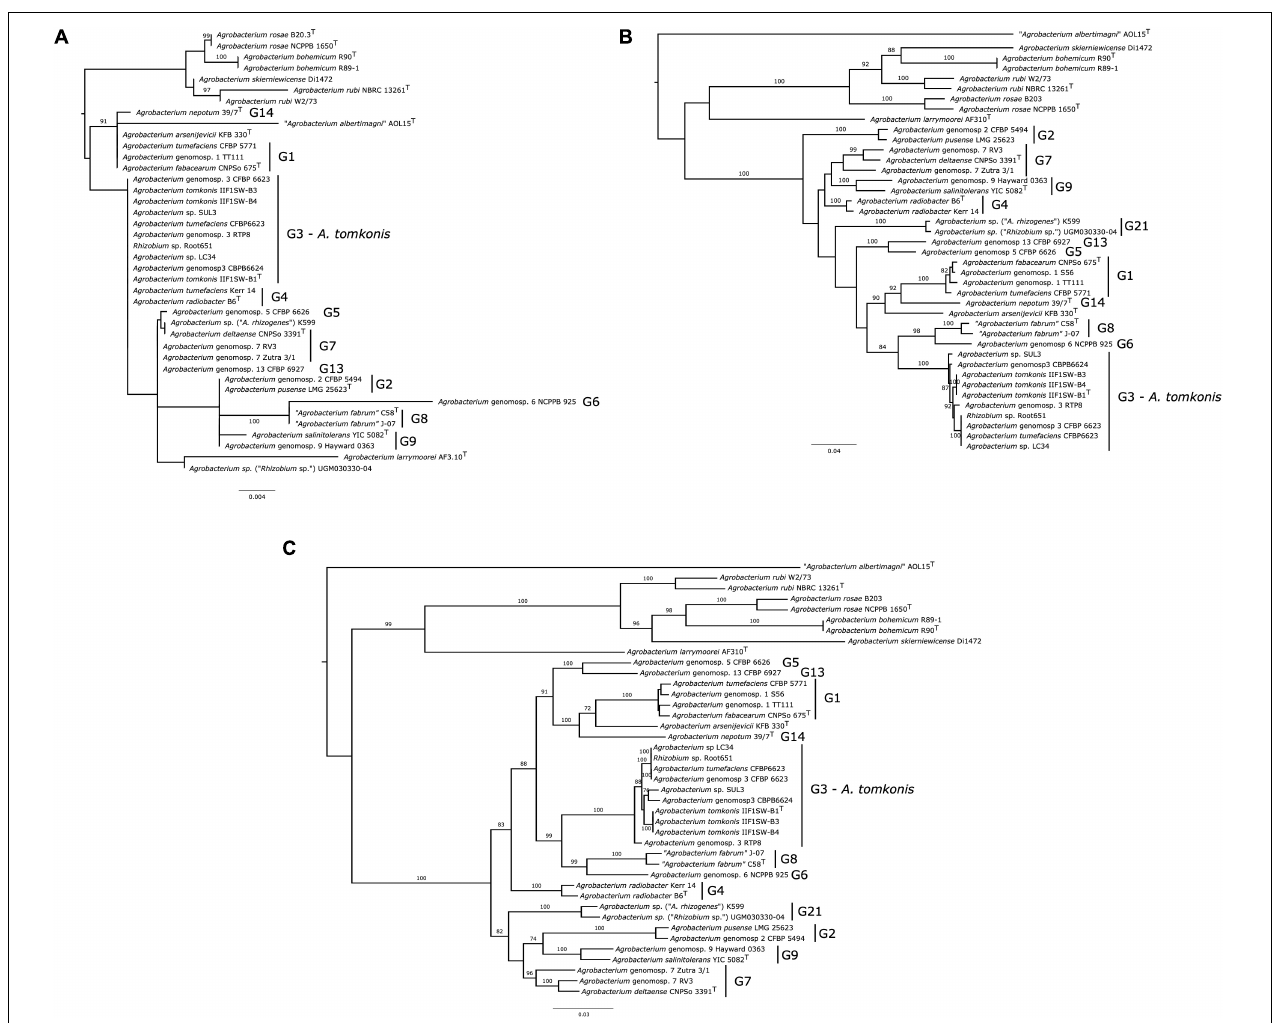
FIGURE 1 | Phylogeny of 40 Agrobacterium spp. strains based on 16S rRNA gene, gyrB , and MLSA. Conserved marker gene phylogenies of 40 Agrobacterium distinct strains (41 when including the two published genome versions for strain CFBP 6623. (A) 16S rRNA gene phylogeny, based on 1,602 aligned positions), rooted with sequence from Rhizobium leguminosarum USDA 2370 T ; (B) gyrB gene phylogeny, based on 2,477 aligned positions; (C) multi-locus sequence analysis phylogeny, based on the concatenated alignments of genes parE , gyrB , recA, and rpoB , resulting into 9,968 aligned positions. All gene sequences were extracted from the 41 studied and then aligned with Clustal Omega (for coding genes, alignment was performed at the protein level and then reverse-translated into codons). Maximum-likelihood trees were inferred with RAxML-NG 1.0.0 under the model GTR + FO + G4m, taking the best of 20 independent inferences, started with 10 random trees and 10 parsimony-optimized tree. Branch supports were estimated with 200 Felsenstein bootstrap trees. Only branch support over 70% are displayed; full information on the trees are available at https://doi.org/10.6084/m9.figshare.14792148; https://doi.org/10.6084/m9.figshare.14792169;